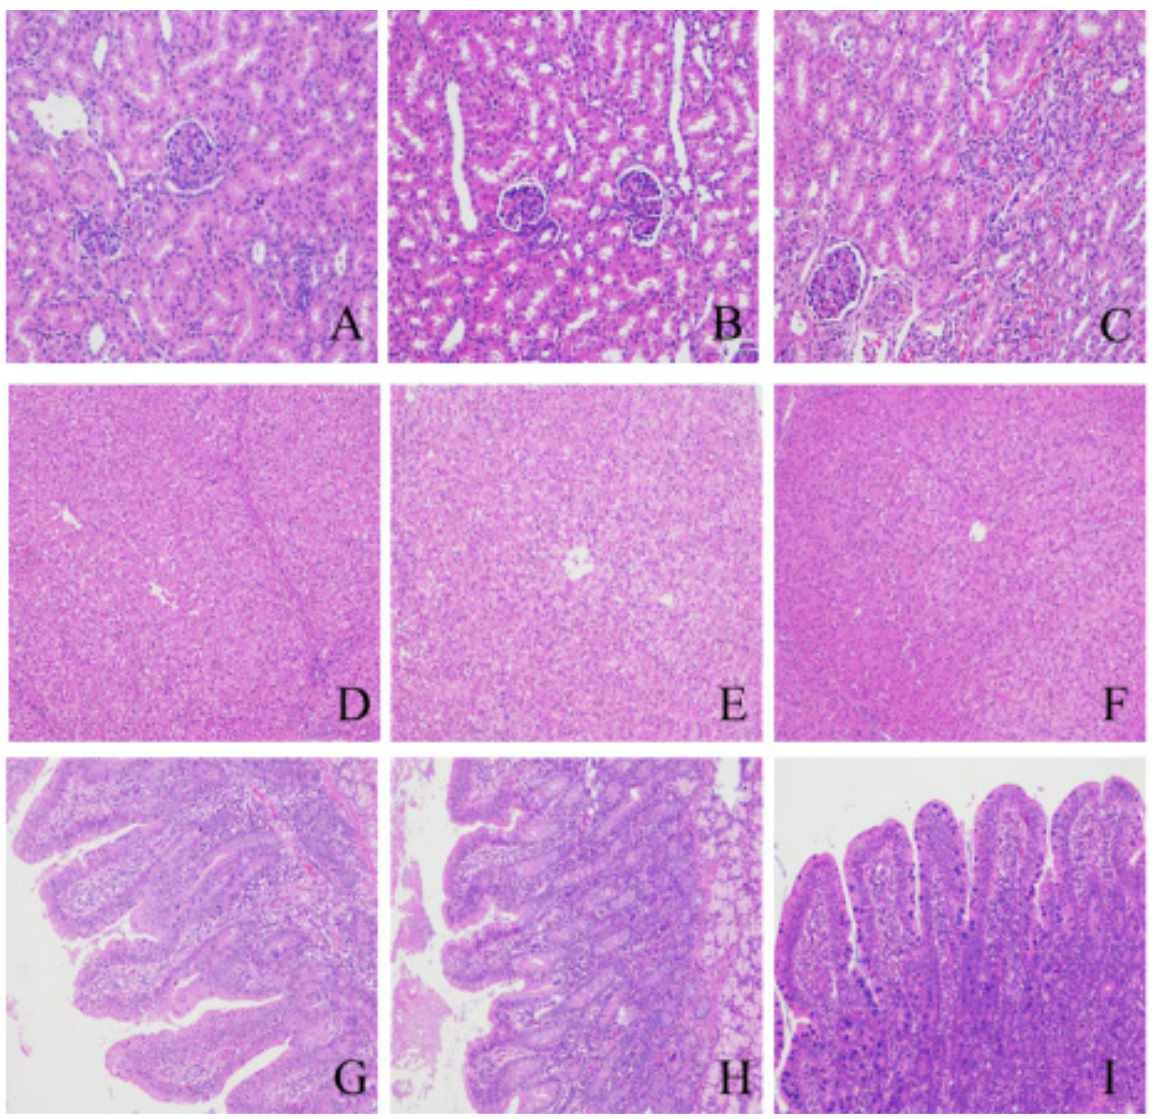
Figure 3. Histopathological examination of the kidney (H&E, 200×), liver and intestinal (H&E, 100×). (A), (B), and (C) were histopathological examinations of the kidney of pigs fed the basal diet and basal diet with 150 or 1,500 mg/kg sucralose, respectively. (D), (E), and (F) were histopathological examinations of the liver of pigs fed the basal diet, and basal diet with 150 or 1,500 mg/kg sucralose, respectively. (G), (H), and (I) were histopathological examinations of the small intestinal (duodenum) of pigs fed the basal diet, and basal diet with 150 or 1,500 mg/kg sucralose, respectively. H&E, haematoxylin and